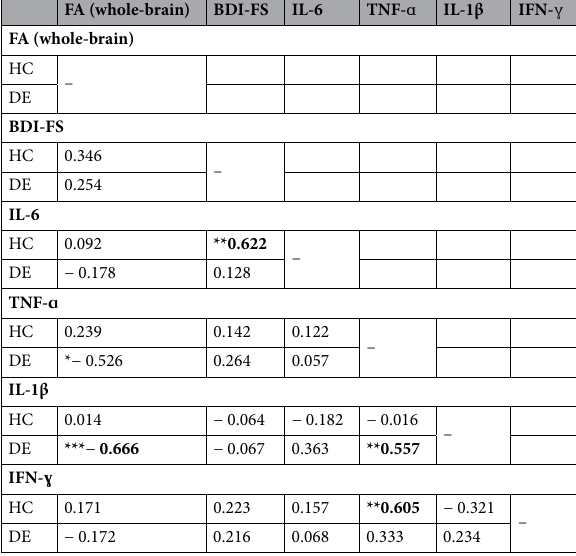
Table 2. Spearman rank correlations between FA (whole brain), BDI-FS values, IL-6, TNF- ɑ , IL-1β, and IFN- ɣ . Correlations are controlled for the variables age and BMI. p values are marked as following: *p < 0.05, **p < 0.01, ***p < 0.001. Moreover, p values lesser or equal than the Bonferroni adjusted threshold (P BONF = 0.01) are marked in